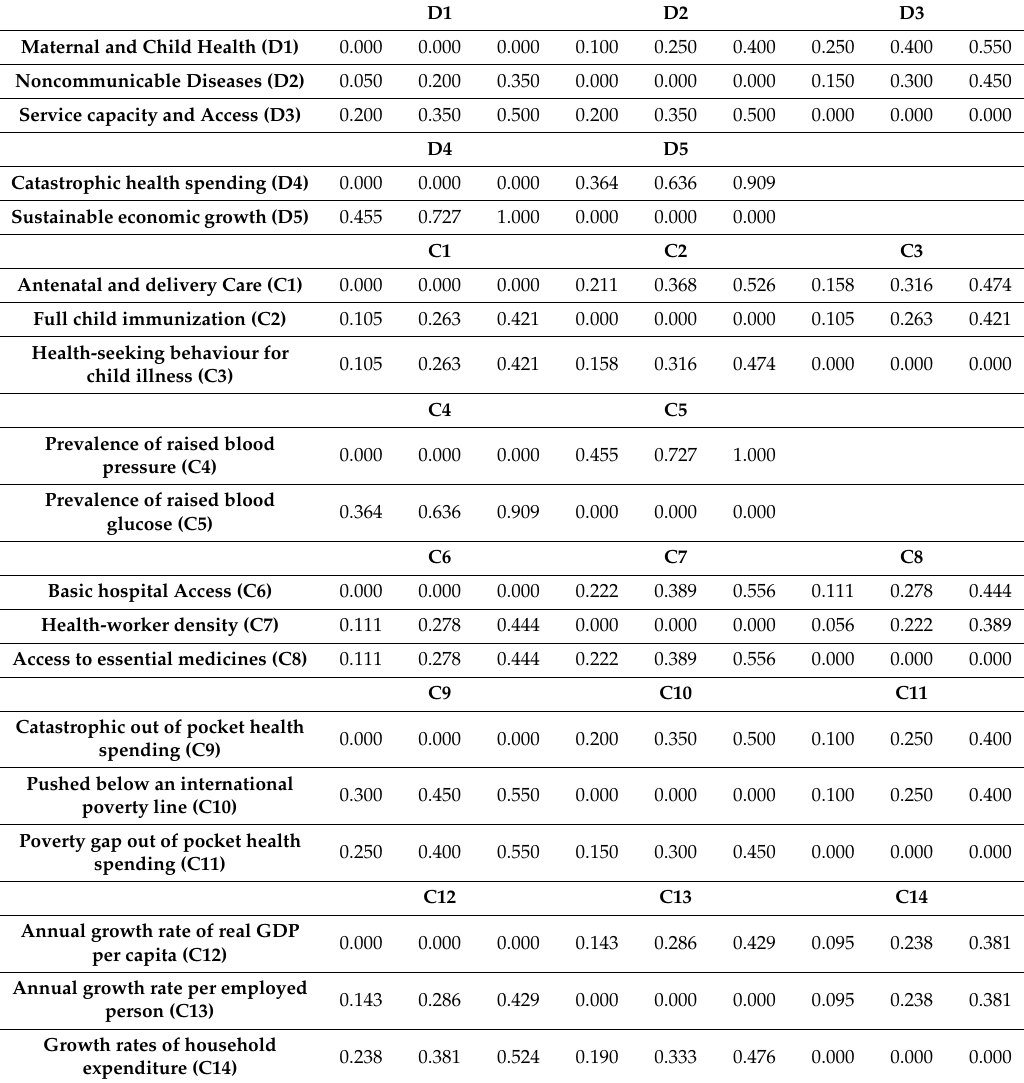
Table A2. Normalized Direct-Relation Fuzzy Matrices.